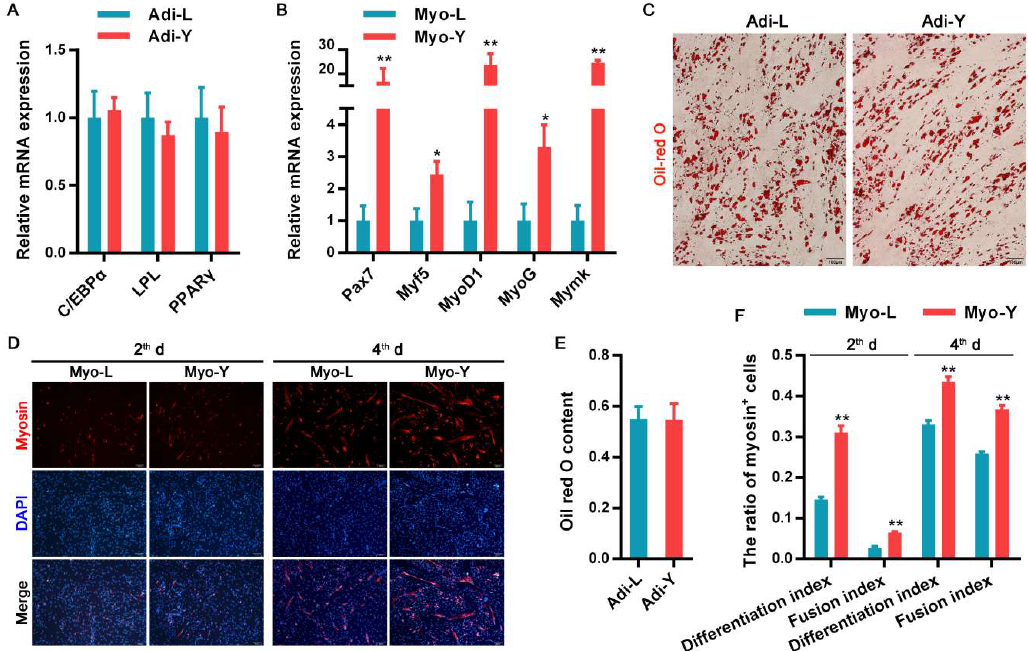
Figure 1. Differentiation potential comparison of Adi-lineage and Myo-lineage cells derived from porcine skeletal muscle between obese- and lean-type pigs ( n = 3). ( A ) The mRNA expression of adipogenesis-related genes. ( B ) The mRNA expression of myogenesis-related genes. ( C ) Oil-red O staining after adipogenic induction. ( D ) Myosin expression visualized by immunofluorescence at the 2th or 4th day during myogenic induction. ( E ) Oil-red O content quantified by spectrophotometer. ( F ) Differentiation index and fusion index of Myo-lineage cells after differentiation. * means p < 0.05, and ** means p < 0.01. The magnification of the microscope is 10 × 10. Adi-L and Adi-Y represent Adi-lineage cells derived from skeletal muscle of obese- and lean-type pigs, respectively. Myo-L and Myo-Y represent Myo-lineage cells derived from skeletal muscle of obese- and lean-type pigs, respectively.